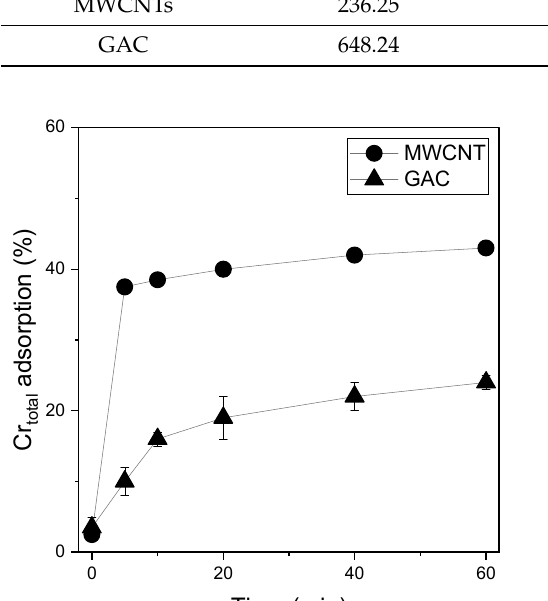
Figure 3. Reduction % of Cr(VI), Fe(III) and UV absorbance appearance at 730 nm with reduction of PMo 12 O 403 − by MWCNT and GAC at acidic pH condition, respectively, ( a ) at 5 min and ( b ) at 60 min ([Fe(III)] o = 0.2 mM, [Cr(VI)] o = 0.1 mM, [PMo 12 O 403 − ] o = 1.0 mM, [CNT] o = [GAC] o = 2.0 g/L, pH o = 3, anaerobic condition, [reaction time = 6 and 60 min]).